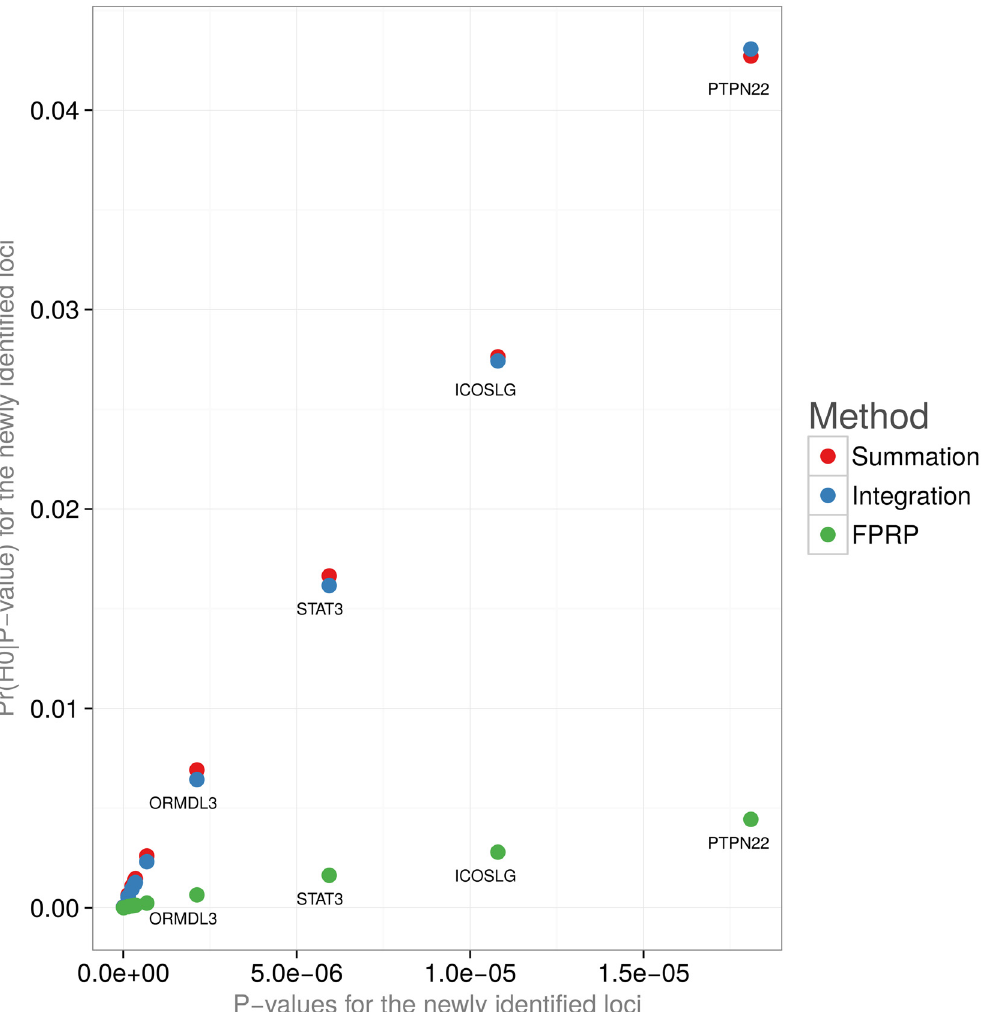
Fig 6. Posterior probabilities of the null hypothesis by POFIG and FPRP methods. The posterior probabilities are calculated for the newly identified Crohn ’ s disease associations from Barrett et al. ’ s study [13]. Unmarked genes in the lower left corner: IL12B, LRRK2-MUC19, C11orf30, CDKAL1, CCR6, ITLN1 — for red and blue; IL12B, LRRK2-MUC19, C11orf30, CDKAL1, CCR6, ITLN1, JAK2 — for green